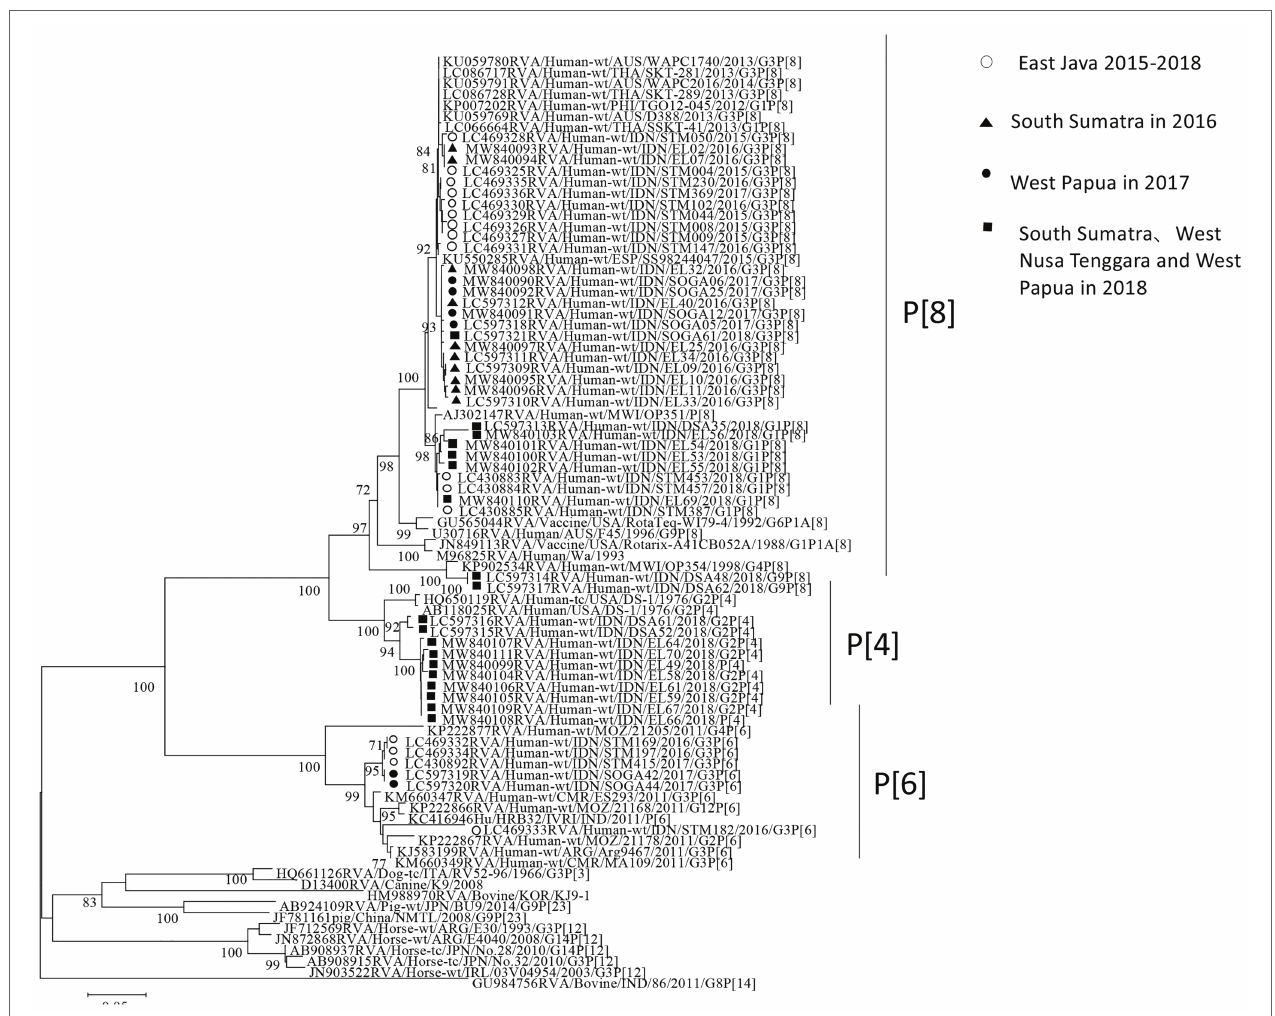
FIGURE 3 | Phylogenetic analysis of the RVA VP4 (P genotype) gene. The tree was constructed using the neighbor-joining method. Bootstrap values (>70) are shown at the branch nodes. The strains in this study are indicated by closed circles (West Papua in 2017), closed triangles (South Sumatra in 2016), closed squares (South Sumatra, West Nusa Tenggara, and West Papua in 2018) and open circles (East Java in